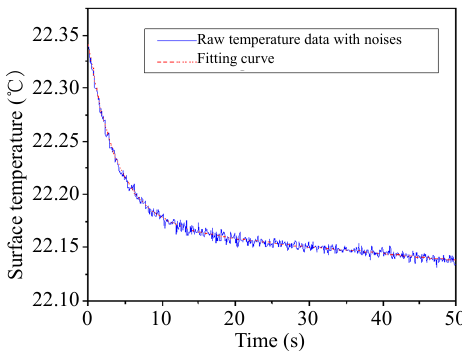
Fig.7 Fitting of temperature sequence containing pixel noise.